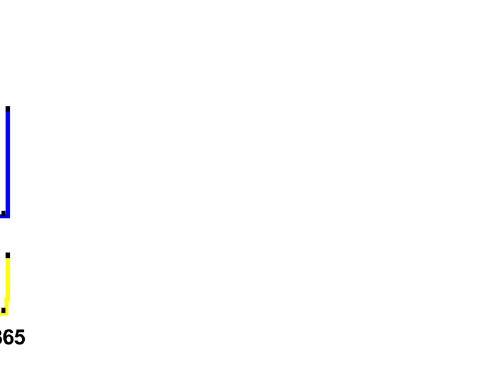
Figure 5. Cumulative incidence of arrhythmia recurrence after blanking period for low and high stages of fibrosis. AF = atrial